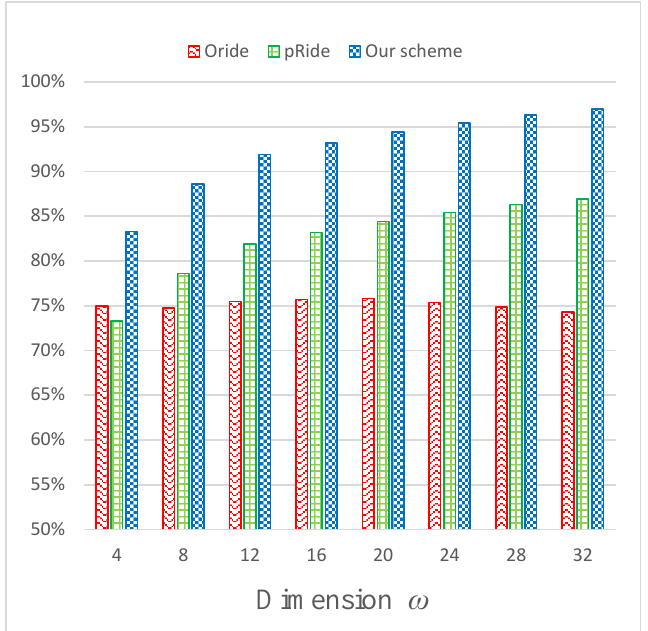
Figure 5. Matching accuracy under different dimension of the road network.